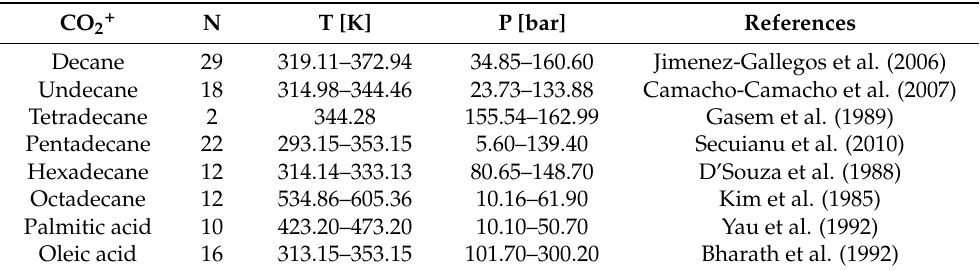
Table 3. Experimental gaseous-liquid equilibrium data for the binary pair’s organic liquid products compounds- i -CO 2 used to compute the binary interaction parameters of RK-Aspen EOS [74–81]. CO 2+ N T [K]